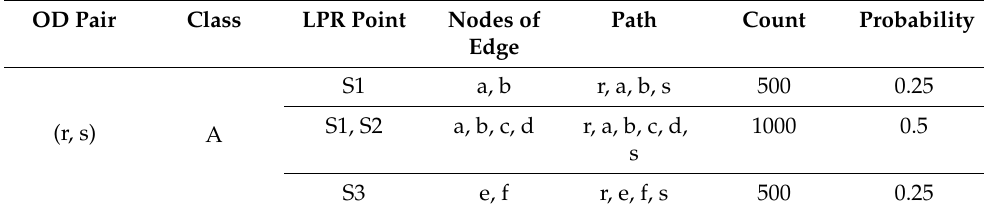
Table 5. Path restoration result of OD pair ( r, s ) by the